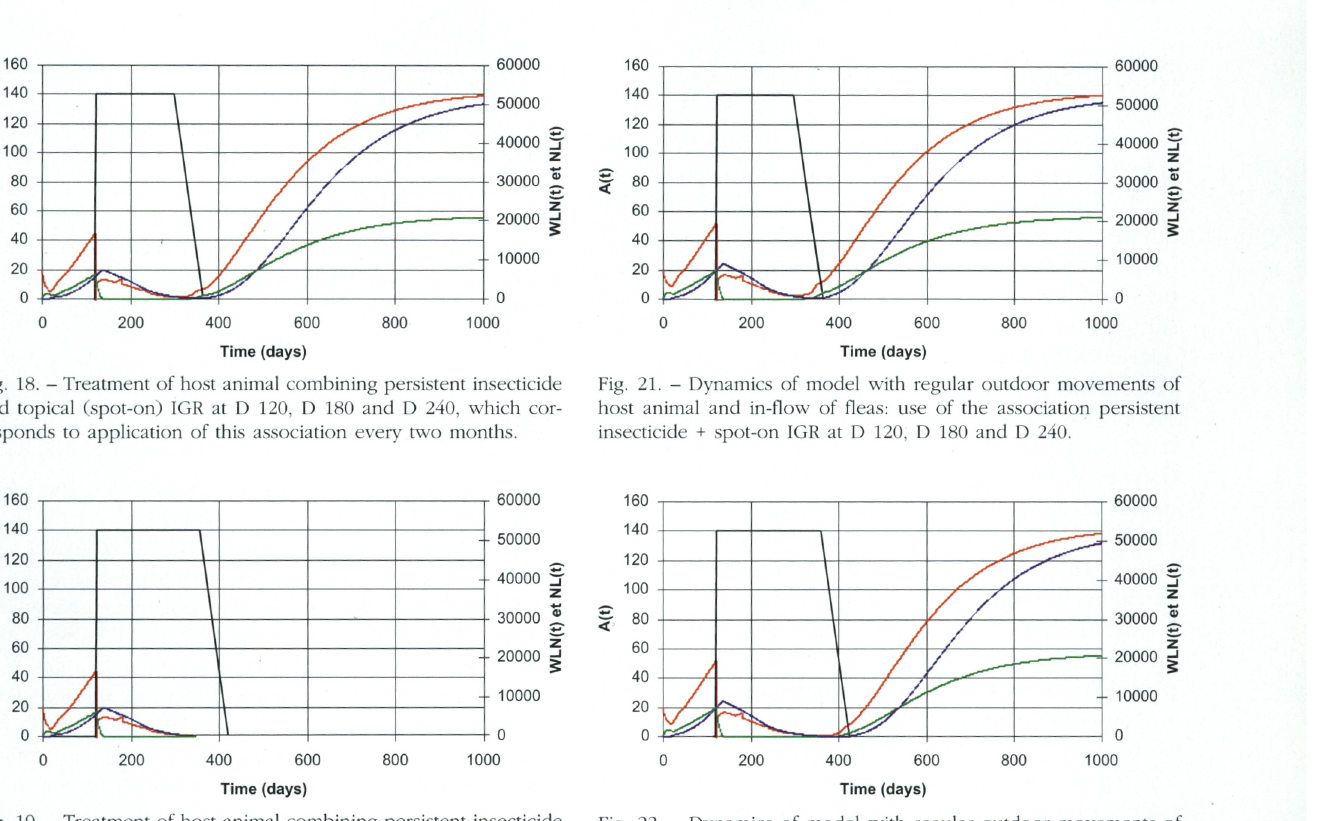
Fig. 22. - Dynamics of model with regular outdoor movements of host animal and in-flow of fleas: use of the association persistent insecticide + spot-on IGR at D 120, D 180, D 240 and D 300.